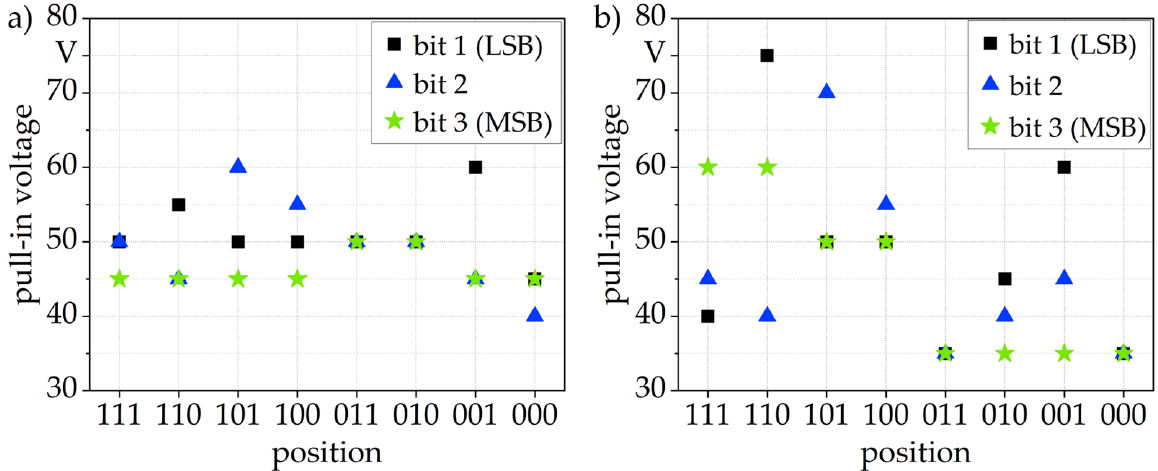
Figure 10. Pull-in voltage of the single bits is dependent on the driven position for ( a ) system 1 and ( b ) system 2. During the experiment, the voltage increased in 5 V-steps, until a pull-in of all the actuators of each single bit was